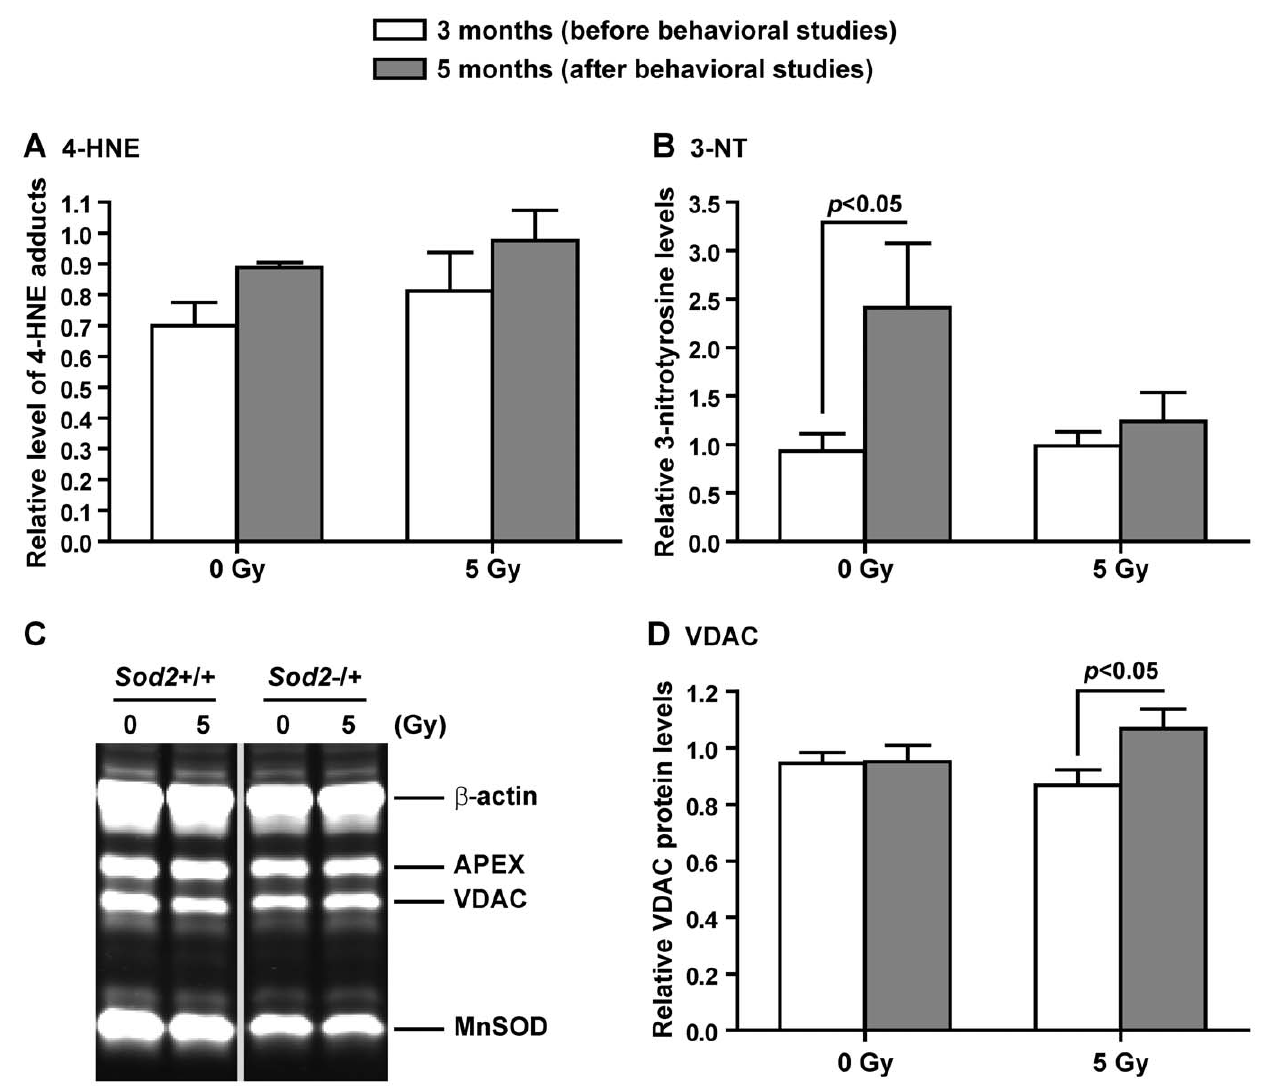
Figure 5. Redox state and mitochondrial mass. Levels of the advanced lipid peroxidation end product, 4-hydroxynonenal (4-HNE) adducts, (A) and protein nitration product 3-nitrotyrosine (3-NT) (B) were determined by ELISA to monitor the extent of oxidative stress in the hippocampus at 3 months and 5 months of age after a single dose of cranial irradiation (see timeline in Figure 3A). C, a representative western blot image from samples collected following behavioral studies showing APEX, VDAC, and MnSOD. D, relative protein levels of VDAC in the Sod2 2 / + cohorts. In order to compare changes in 4-HNE, 3-NT, and VDAC levels in sham and irradiated Sod2 2 / + from two different experimental stages – at 3 months of age before behavioral studies and at 5 months of age after behavioral studies – levels in Sod2 2 / + mice were calculated as a percentage of their corresponding Sod2 + / + controls. Two-way ANOVA with Bonferroni post test was carried out. P values indicate Bonferroni post test results. There was no treatment 6 time interaction. Data are presented as mean 6 SEM. Sample size: n=5 each at 3 months of age, and 4 each at 5 months of age for sham and irradiated Sod2 2 / + .